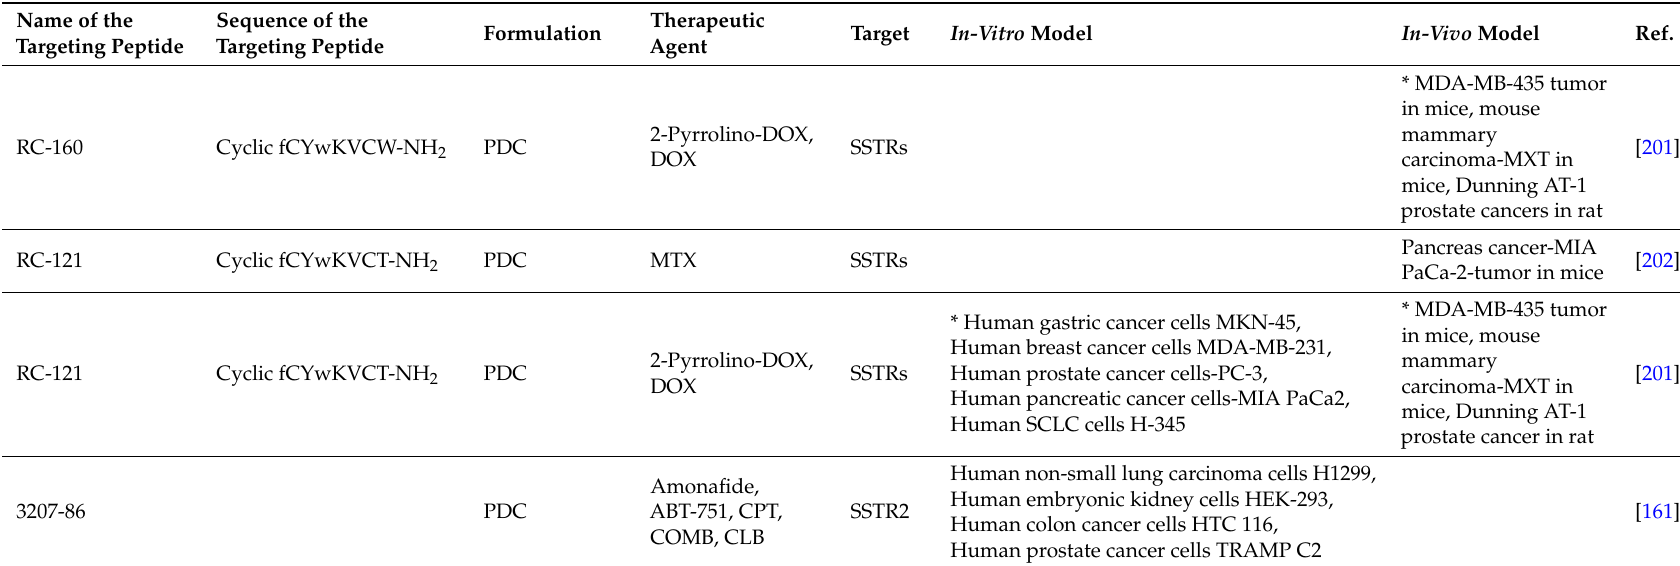
Table 3. Somatostatin cytotoxic analogs. * For additional biological models of these conjugates see